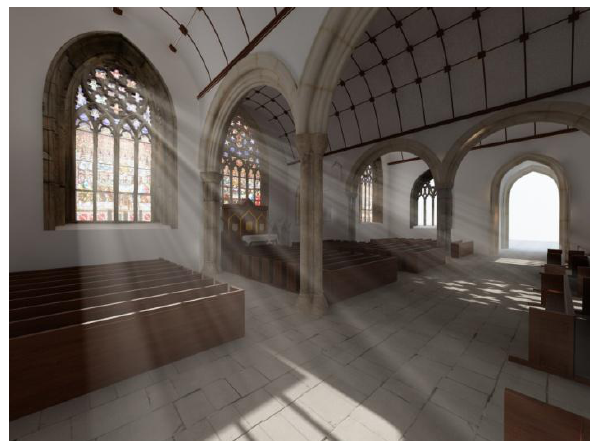
Figure 13 A completed 3D reconstruction of Charles Church.